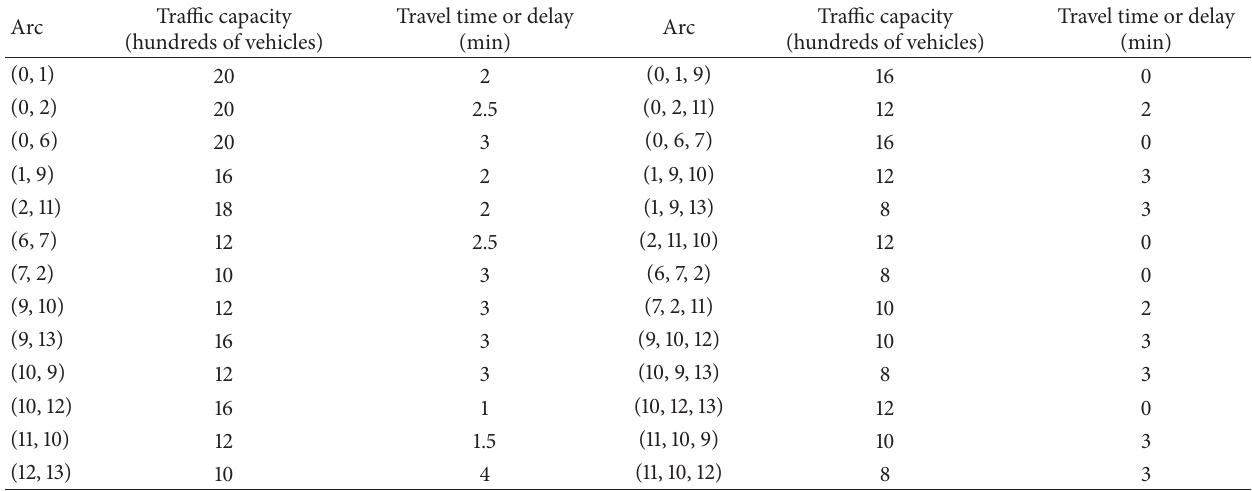
Table 3: Traffic capacity and time schedule of each road section.